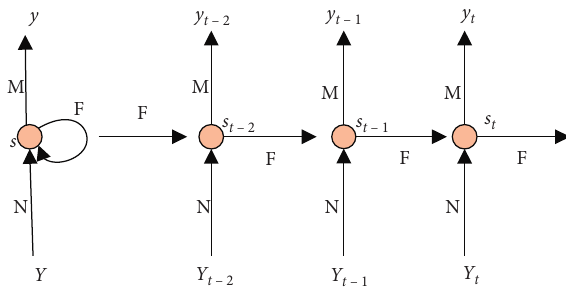
Figure 6: Hidden layer hierarchy expansion